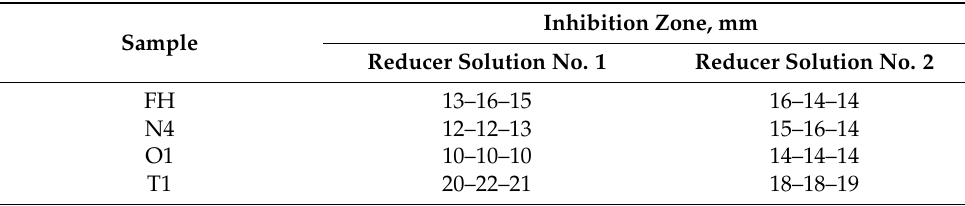
Table 4. Antibacterial activity of textile samples with copper-containing particles. Inhibition Zone, mm Sample Reducer Solution No. 1 Reducer Solution No.